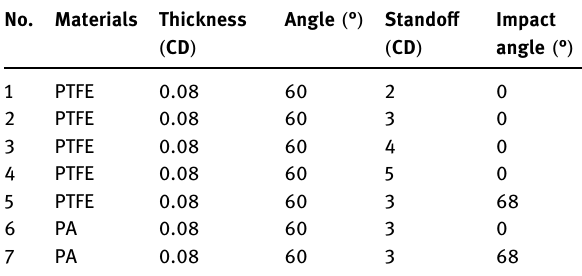
Figure 3: Diagram of test results: ( a ) PA jet and ( b ) PTFE jet.